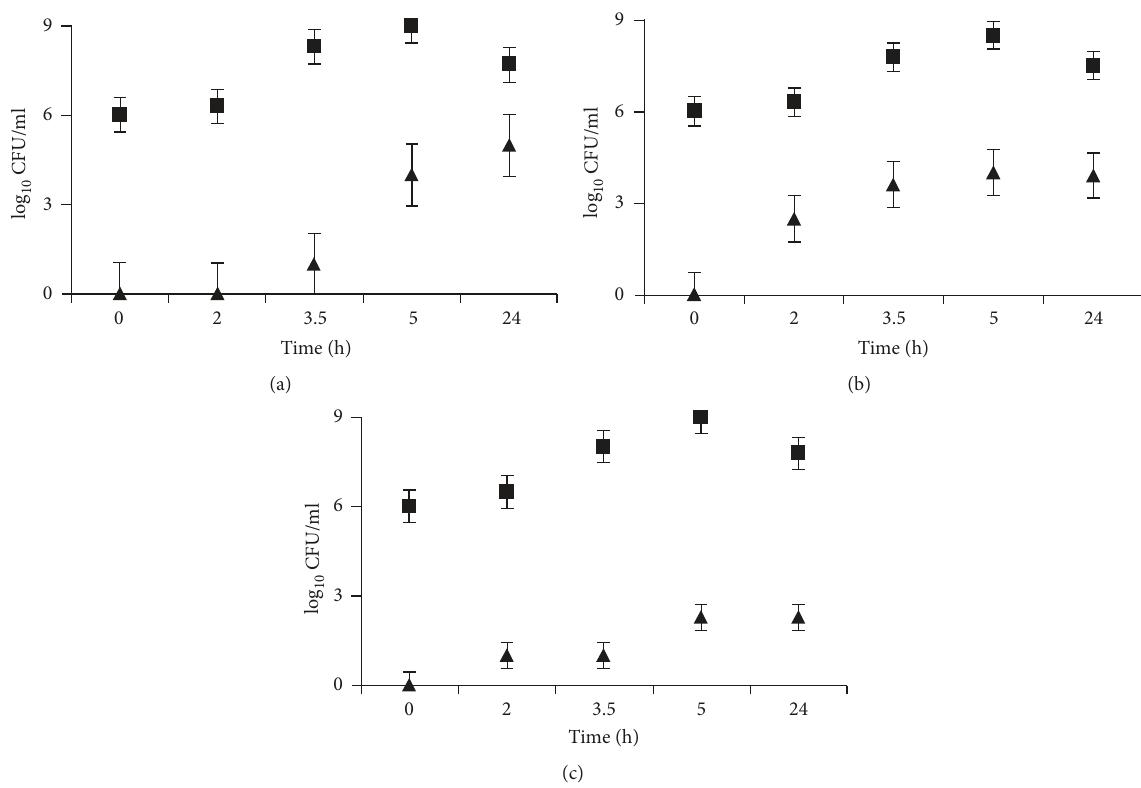
Figure 2: log 10 of total number of vegetative cells and spores ( ◼ ) and spores alone ( 󳵳 ) of C. perfringens SM101 produced in BHI medium without (a) and with bile acids (b) and nisin (c). The data represent the averages of three